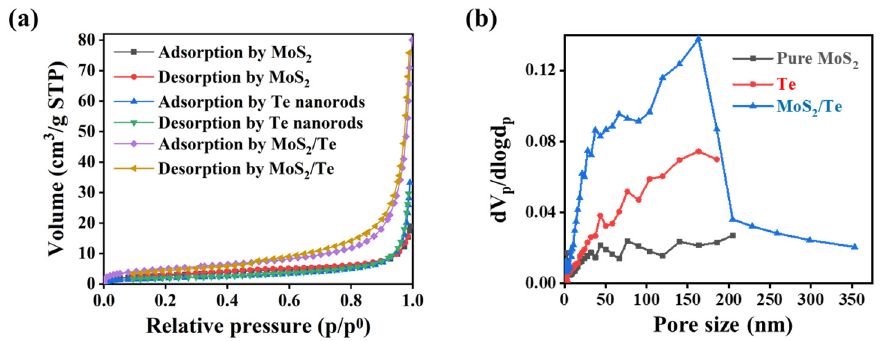
Figure 5. Surface areas and pore sizes of samples: ( a ) N 2 adsorption–desorption isotherms and ( b ) pore size distribution curves for different samples. Table 1. Comparative study of the BET parameters of the samples.